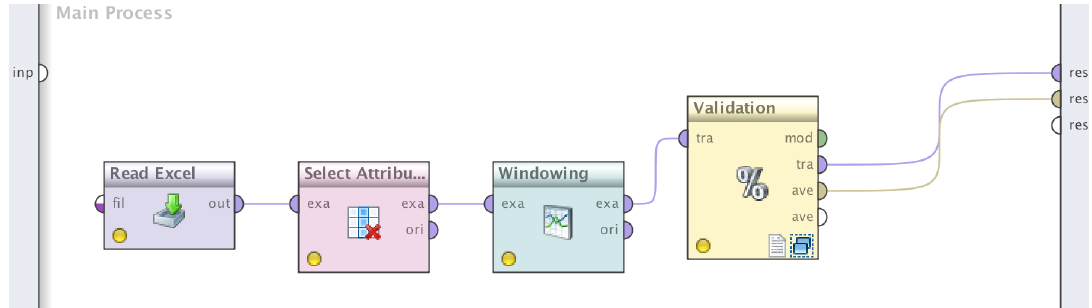
Figure 8. The basic process in the RapidMiner tool.